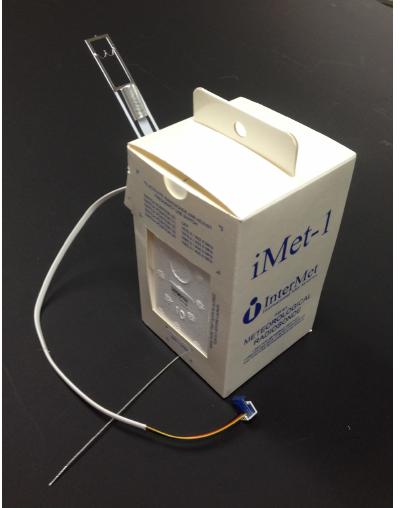
Figure 13. Meteolabor SRS-C34 radiosonde with original thermo- couple temperature sensor fixed to thin wires that extend at a 45 ◦ angle upward (above right) and an additional thermocouple temper- ature sensor at a 45 ◦ angle downward (below